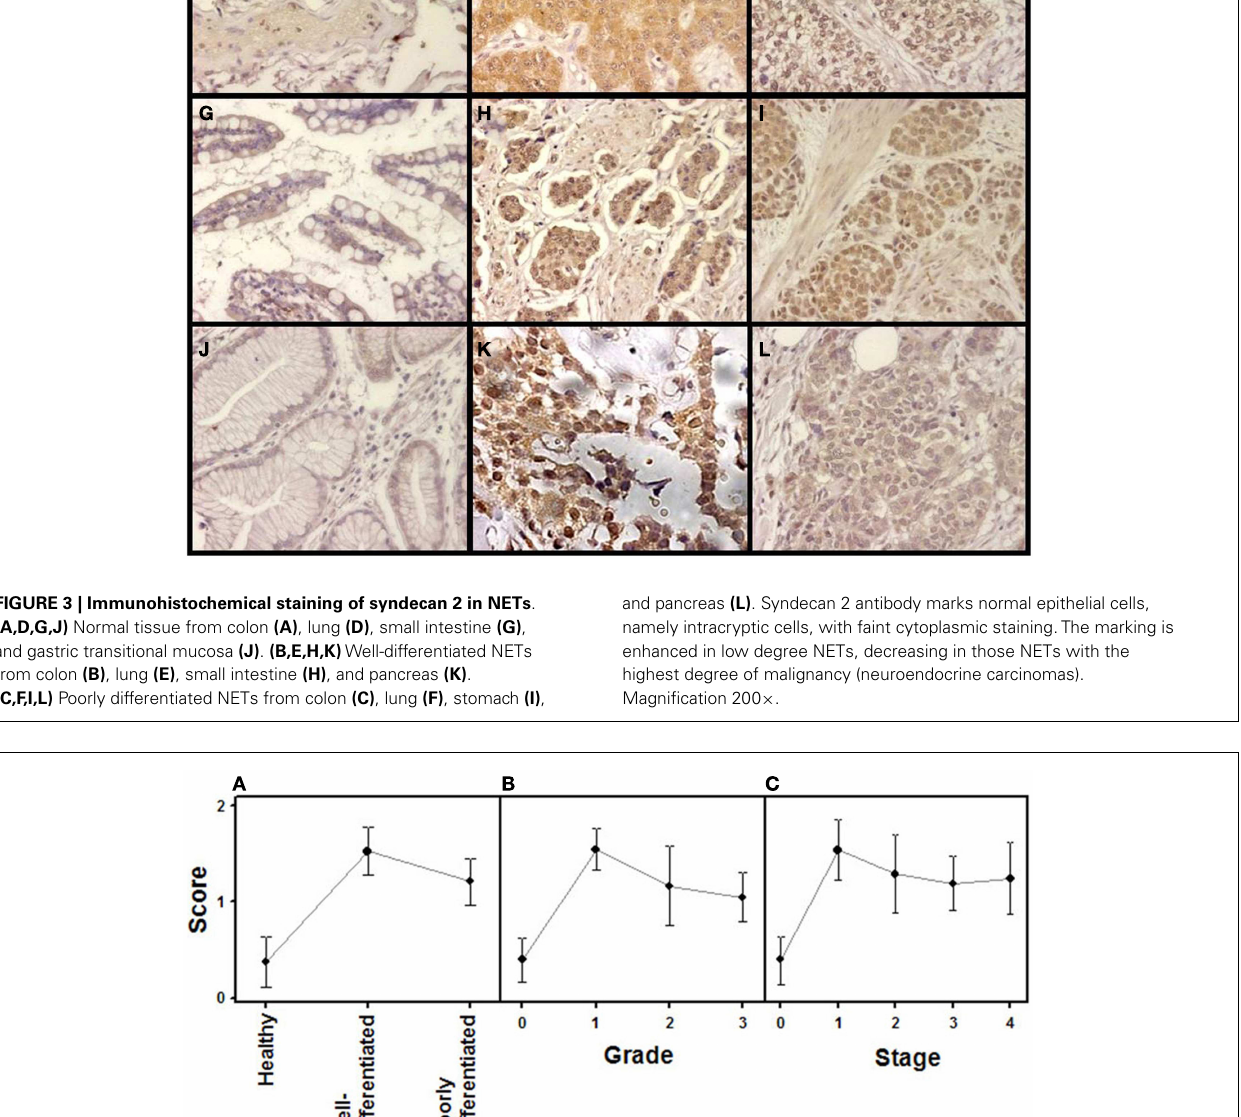
FIGURE 4 | Quantification of immunochemical staining of syndecan 2 . (A) Relative to the tumor differentiation. (B) Relative to tumor grade. (C) Relative to tumor stage. Semiquantitative scale from 0 to ++ was used.Vertical bars denote 0.95 confidence intervals.